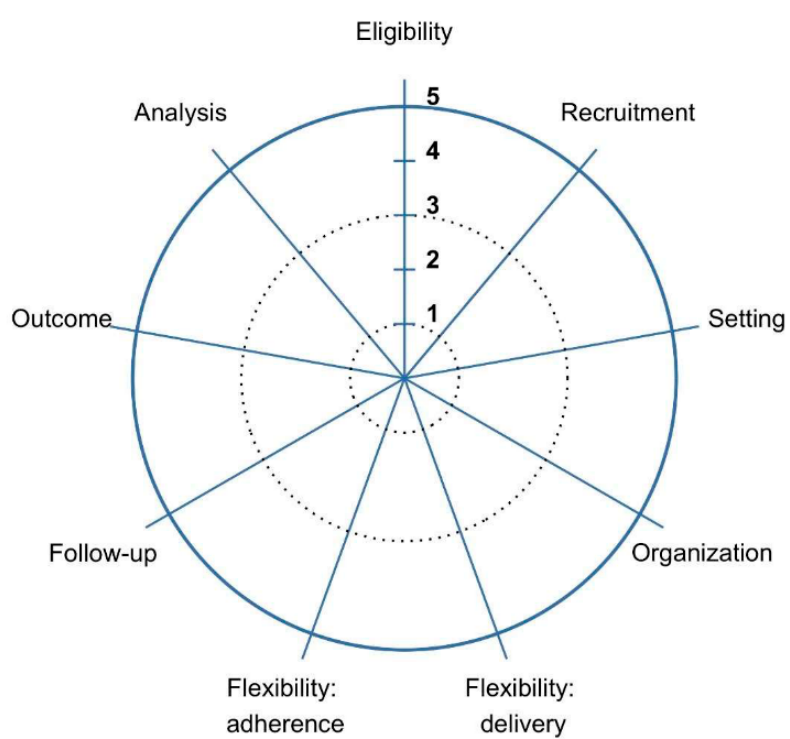
Figure 1. The Pragmatic Explanatory Continuum Indicator Summary 2 (PRECIS-2) wheel ranking the degree of pragmatism for the nine PRECIS-2 domains. The PRECIS-2 nine domains include: eligibility, recruitment, setting, organization, flexibility in delivery, flexibility in adherence, follow-up, primary outcome and primary analysis. It uses a five-point Likert rank scale from very explanatory (1) to very pragmatic (5) to rank each of these